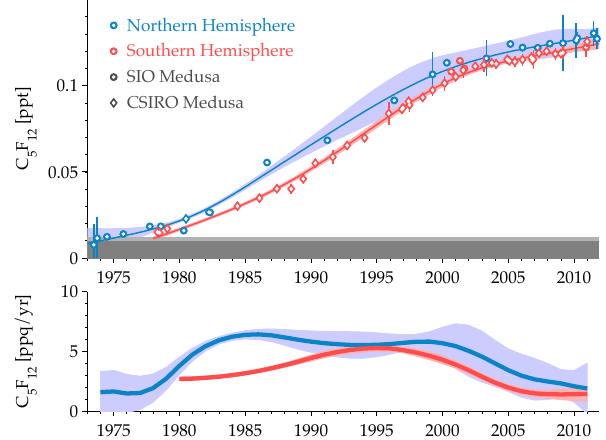
Fig. 2. Same as Fig. 1, but for C 5 F 12 .